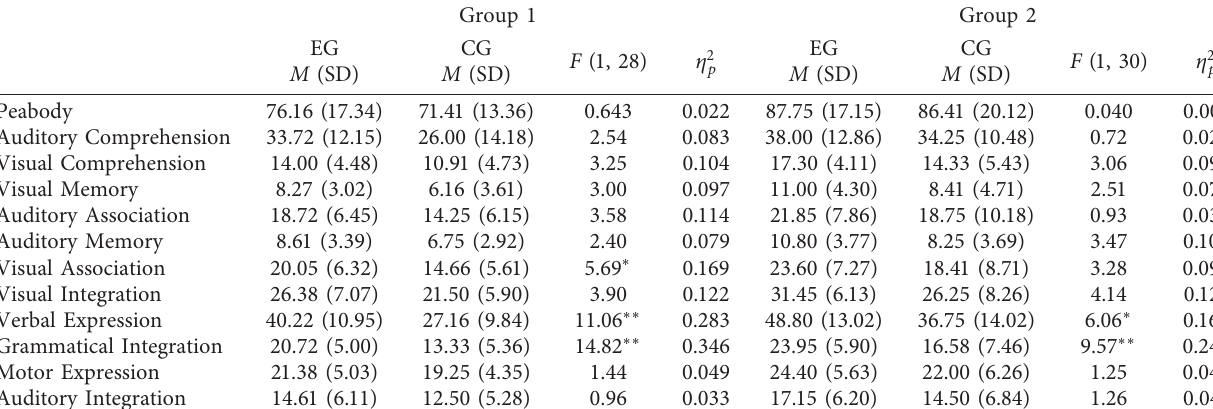
Table 2: Results of the differences between the two age groups.